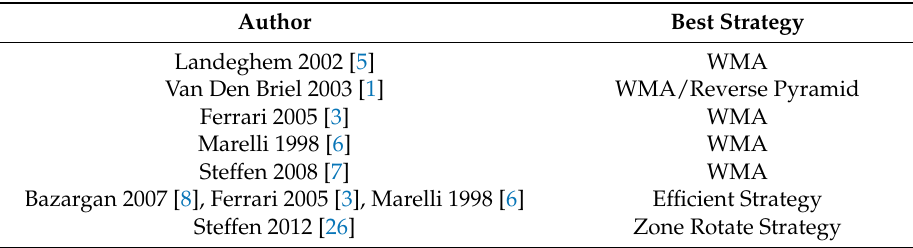
Table 4. Literature survey of comparative